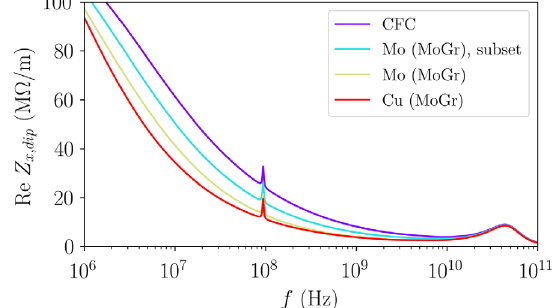
FIG. 9. Low-impedance secondary collimators decrease the machine ’ s horizontal dipolar impedance (real part plotted along the vertical axis) at the top energy by 30% at the frequencies around 1 GHz, relevant for the single-bunch coherent beam dynamics. Coating a subset of four collimators provides a half of the reduction. Energy 7 TeV; higher order modes (HOMs) of HL- LHC crab cavities not shown for simplicity. The peak at 10 8 Hz corresponds to a resonance mode of tertiary collimators; the peak around 5 × 10 10 Hz is created by the broadband components of the impedance model such as tapers and BPMs [32,49].